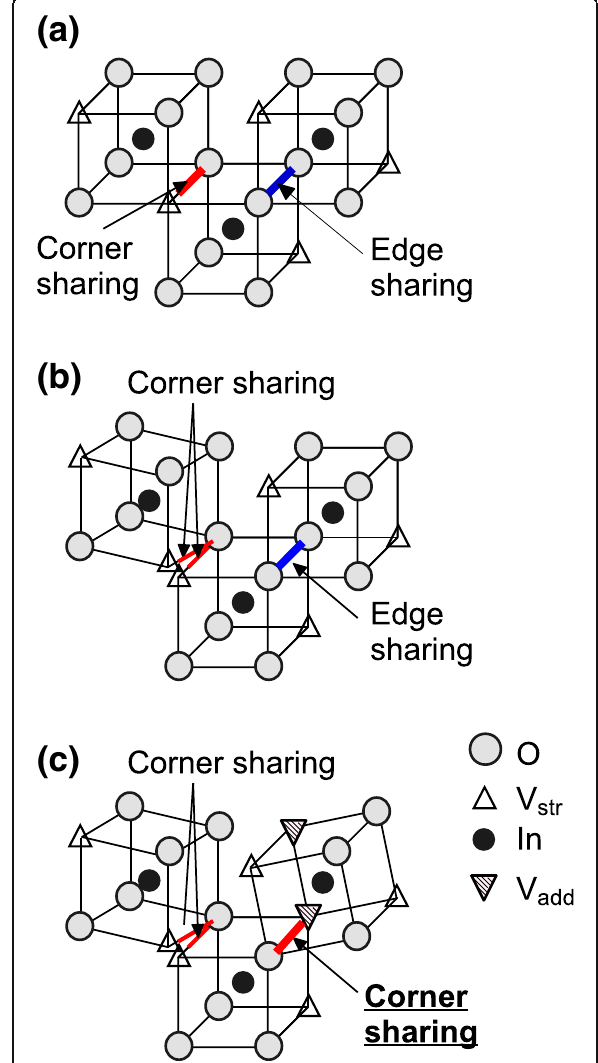
Fig. 6 Models of local structure of a crystalline ITO, b a -ITO, and c very thin a -ITO with added O vacancy defects (V add ), resulting in the transformation from edge sharing to corner